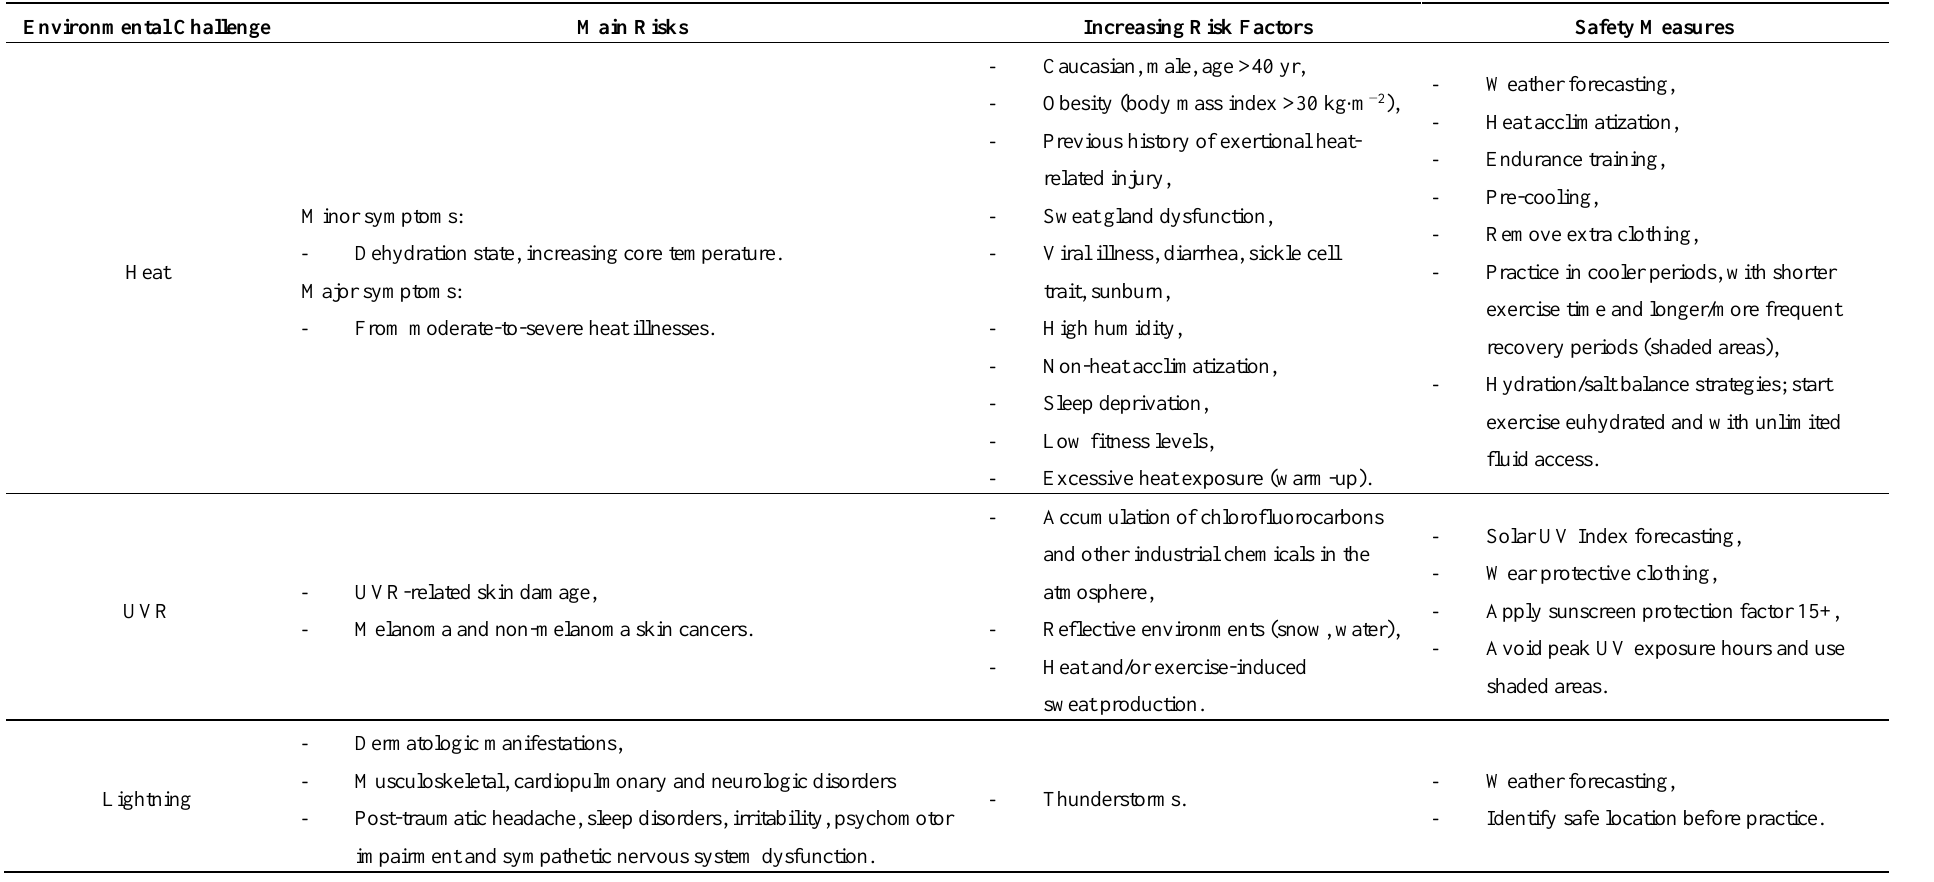
Table 1. Main risks, increasing risk factors and countermeasures for different weather-related conditions in outdoor sports participants. Environmental